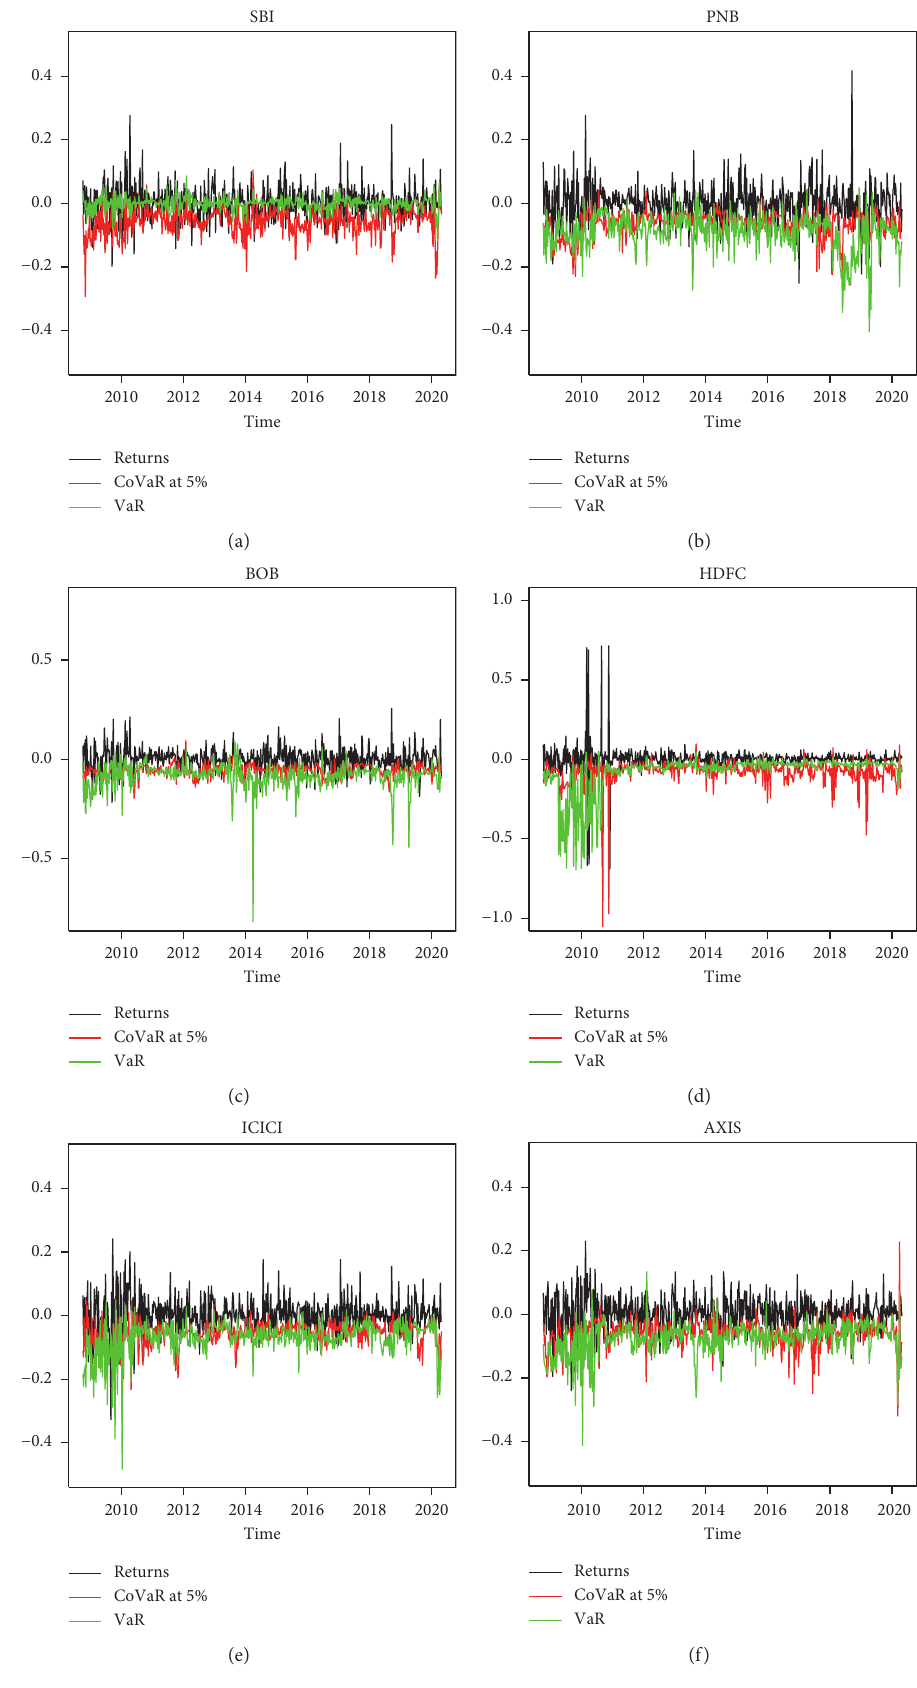
Figure 1: (a) SBI, (b) PNB, (c) BOB, (d) HDFC, (e) ICIC, and (f)